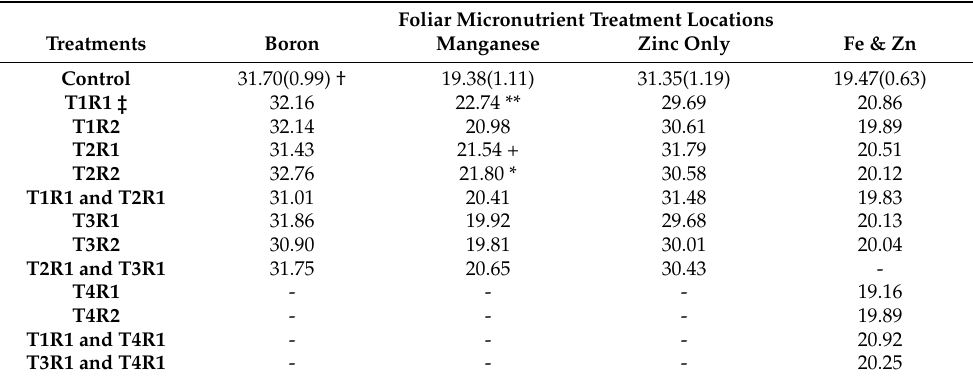
Figure 5. Fe uptake (g Fe ha − 1 ) and partitioning graphs. Solid and dashed lines represent foliar Fe/Zn treated plots and control plot, respectively. Solid vertical lines represent the time of application expressed as days after sowing. ( a – k ) corresponds with the treatments. Table 7. Multiple comparison test of LSmean R6 Biomass (Mg ha − 1 ) comparing treatment effects with control using Dunnett’s